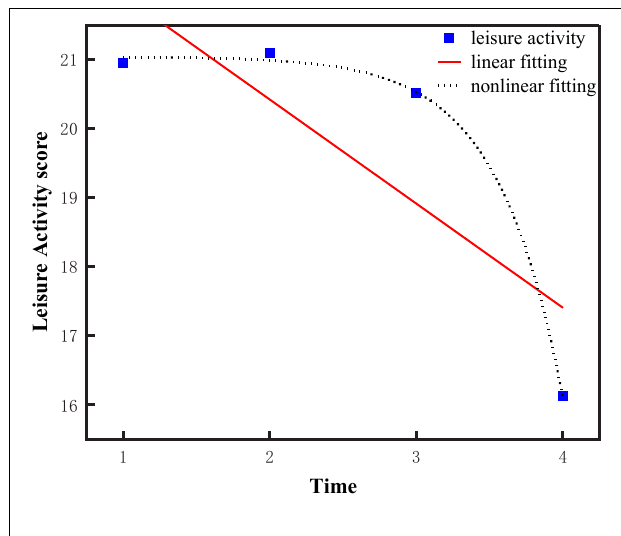
FIGURE 6 | Leisure activity